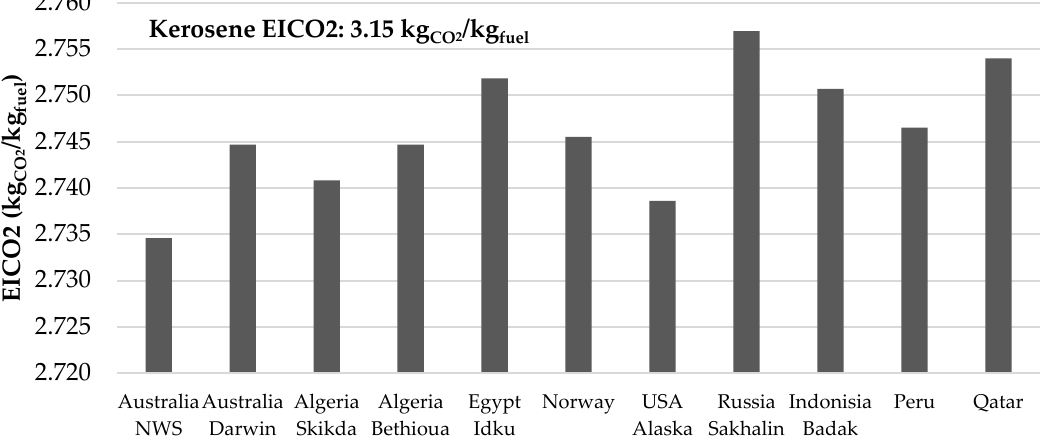
Figure 3. Variations in density per region at 113.15 K.